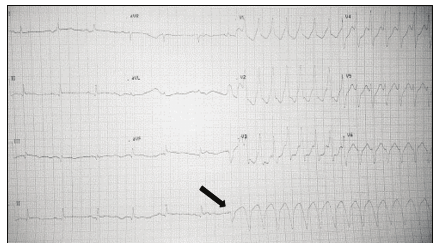
Figure 1: Baseline ECG of the patient, showing ST coving in inferior Figure 3: Monomorphic VT clearly appears to be starting with a suggestive of inferior wall MI along leads { II, III, and aVF } , and V 5 fusioncomplexofthepacedandintrinsicbeats(indicatedbyarrow). - 6 with 2 : 1 atrioventricular block.